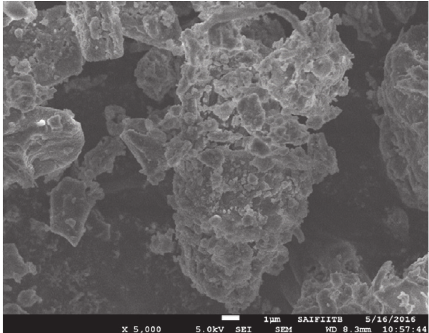
Figure 5: SEM micrograph of prepared rice straw ash.